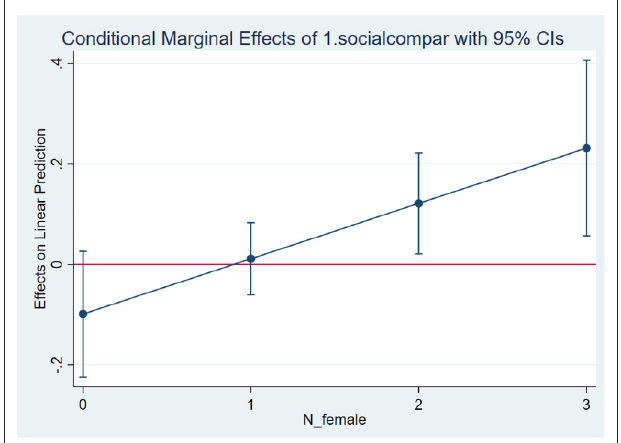
FIGURE 6 | Conditional marginal effects of N of females in household.